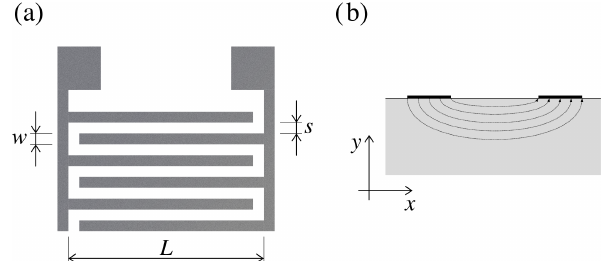
Figure 3. The geometry of the interdigital electrodes for conduc- tivity measurement (a) and schematic cross section of the speci- men with two fingers visible (b) . Due to the inhomogeneous electric field, a conversion from the xy space is necessary. Details follow in the